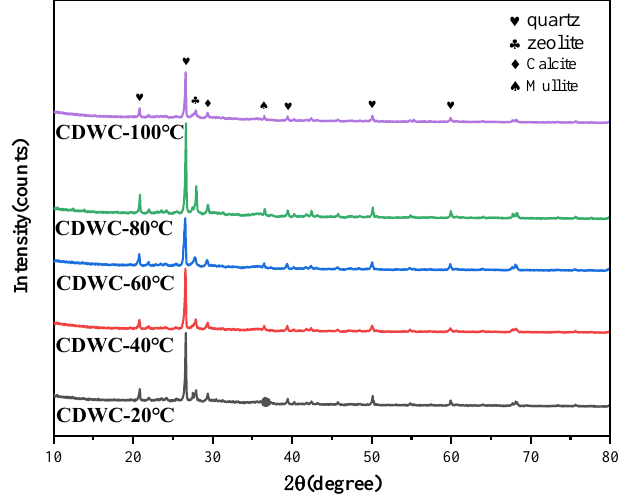
Figure 6. XRD results of CDWC after different pretreatment temperatures.